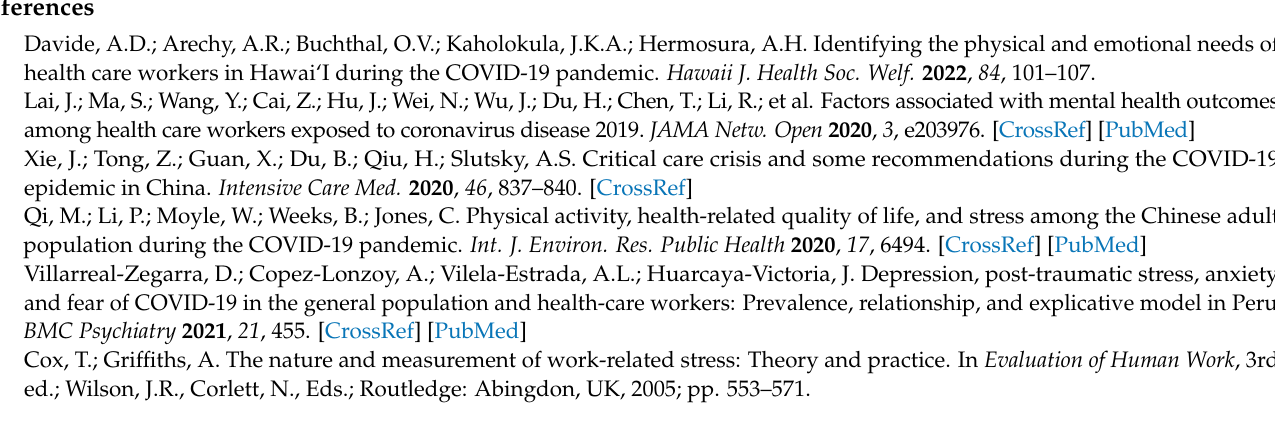
Table S2: The differences between the severity of work-related traumatic stress responses